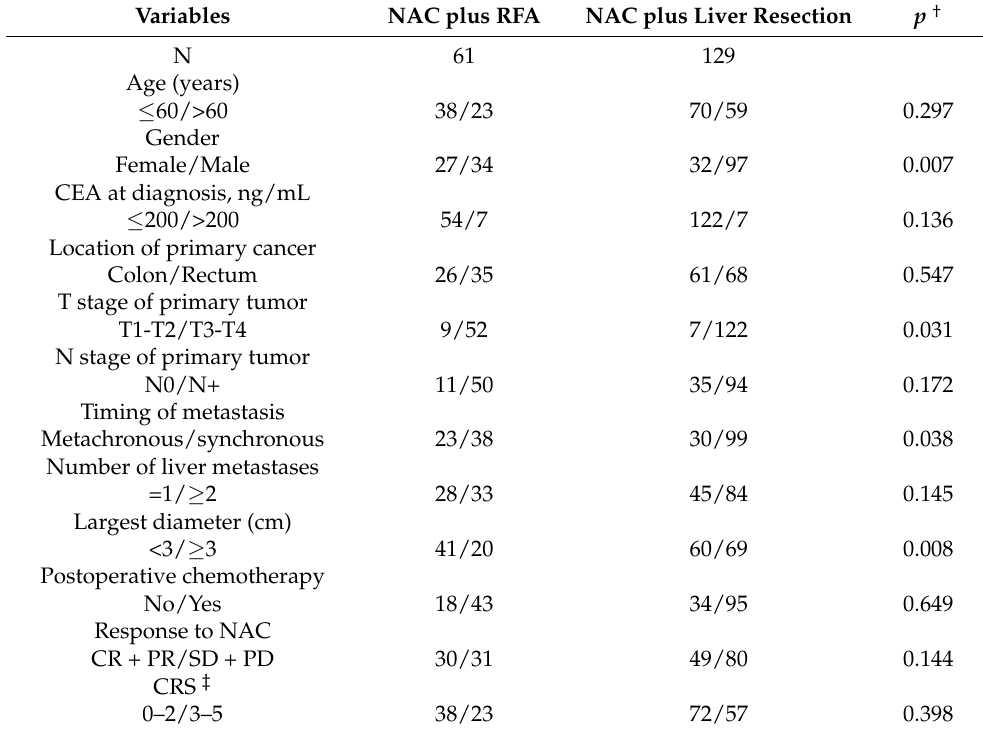
Table 1. Baseline characteristics of the